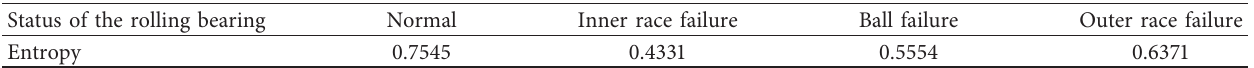
Table 6: Entropy value of four states of the rolling bearing.